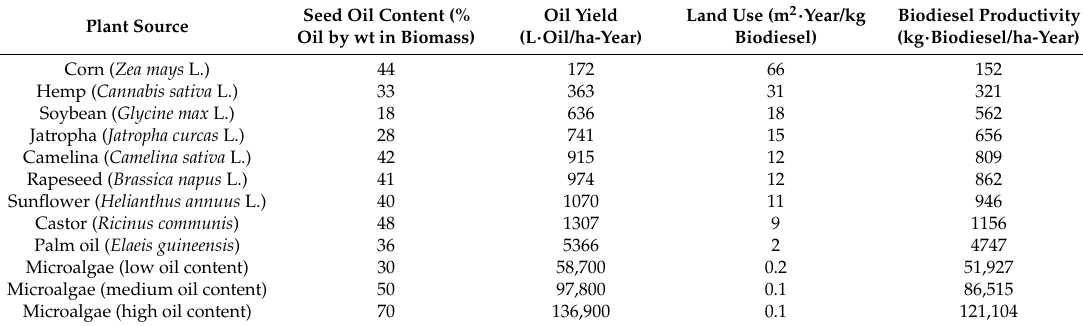
Oil Yield Biodiesel Productivity Land Use (m 2 · Year/kg (L · Oil/ha-Year) (kg · Biodiesel/ha-Year) Biodiesel)